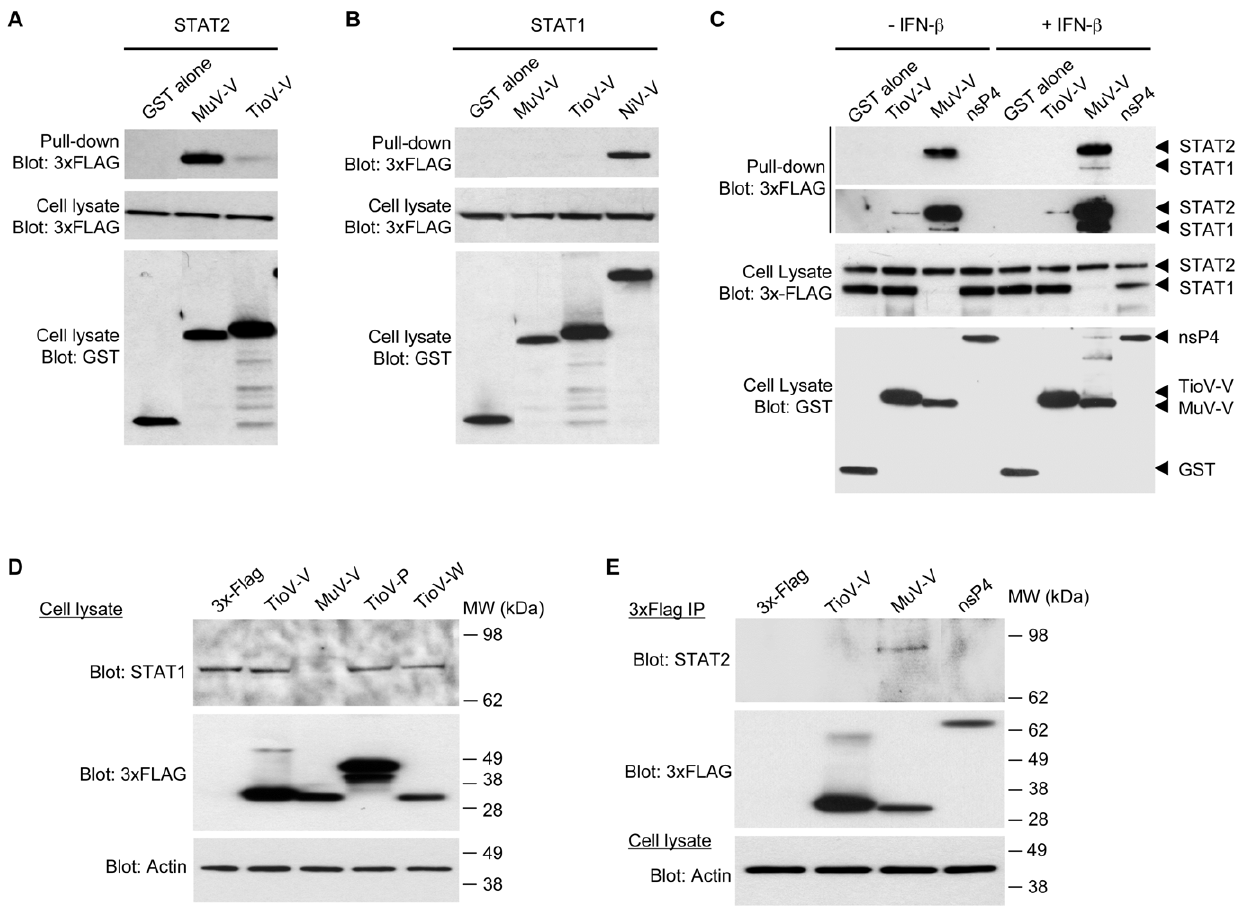
Figure 7. TioV-V fails to interact with human STAT2 and does not induce STAT1 degradation. ( A–B ) HEK-293T cells were co-transfected with expression vectors encoding GST alone or fused to MuV-V, TioV-V ( A–B ) or NiV-V ( B ) (500 ng/well), and pCI-neo-3xFLAG expression vectors (300 ng/well) encoding for 3xFLAG-tagged human STAT2 ( A ) or STAT1 ( B ). Total cell lysates from transfected cells were prepared at 48 h post- transfection (cell lysate; middle and lower panels), and protein complexes were assayed by pull-down using glutathione-sepharose beads (GST pull- down; upper panel). 3xFLAG- and GST-tagged proteins were detected by immunoblotting. ( C ) HEK-293T cells were co-transfected with expression vectors encoding GST alone or fused to TioV-V, MuV-V or CHIKV-nsP4 (500 ng/well), and pCI-neo-3xFLAG expression vectors encoding for 3xFLAG- tagged human STAT1 and STAT2 (150 ng/well of each vector). At 24 h post-transfection, cells were left untreated or stimulated with recombinant IFN- b at 200 IU/ml. Total cell lysates from transfected cells were prepared at 48 h post-transfection (cell lysate; middle and lower panels), and protein complexes were assayed by pull-down using glutathione-sepharose beads (GST pull-down; upper panels). 3xFLAG- and GST-tagged proteins were detected by immunoblotting. Upper and lower panels on top of figure C correspond to short and longer exposures of the same blot, respectively. ( D ) HEK-293T cells were transfected with pCI-neo-3xFLAG expression vector (1 m g/well) either empty or encoding for 3xFLAG-tagged TioV-V, MuV-V, TioV-P or TioV-W. Total cell lysates were prepared at 48 h post-transfection and endogenous STAT1 expression levels were determined by western- blot analysis. Actin expression was determined and used as a protein extraction and loading control. ( E ) HEK-293T cells were transfected with pCI- neo-3xFLAG expression vector (1 m g/well) either empty or encoding for 3xFLAG-tagged TioV-V, MuV-V or CHIKV-nsP4. Total cell lysates were prepared at 48 h post-transfection, and 3xFLAG-tagged viral proteins were purified using anti-FLAG antibodies conjugated to sepharose beads. Co- immunopurification of endogenous STAT2 with 3xFLAG-tagged viral proteins was determined by western-blot analysis (top and middle panel, respectively). Actin expression was determined prior to the immunoprecipitation on total cell lysates and used as a protein extraction control (lower